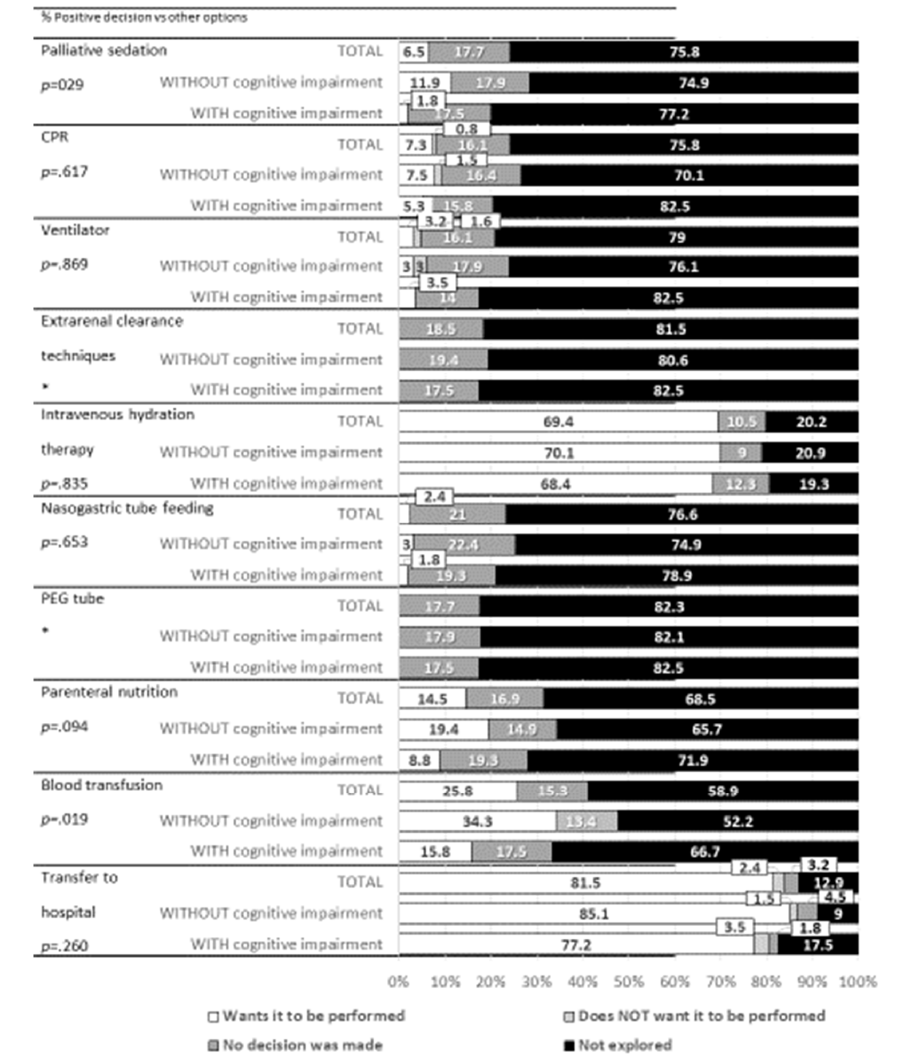
Figure 1. Decision making on specific interventions. * No analysis was possible due to a lack of cases.